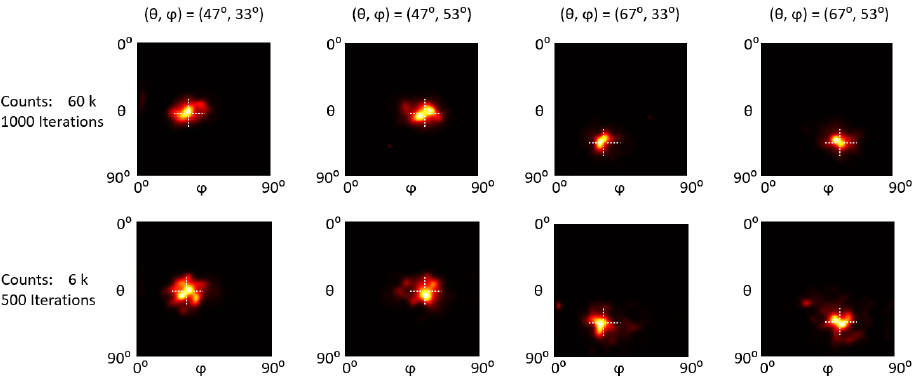
Figure 9. Reconstruction images of a 57 Co point sources at different positions with different count levels. The intersections of the dotted lines indicate the actual positions.